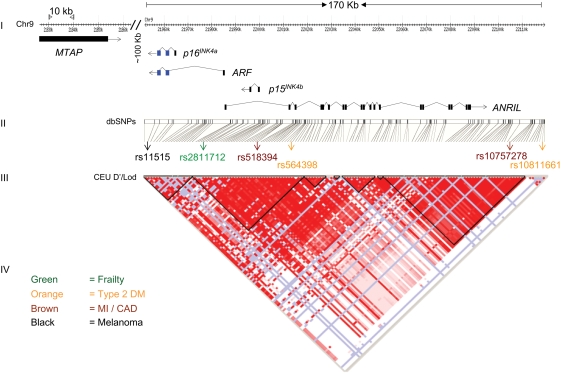
The human INK4/ARF locus and CAD associated SNPs.(I) INK4/ARF-associated transcripts and tested SNPs are shown as well as the location of MTAP, another gene at 9p21. Blue colored boxes indicate exons 2 and 3 shared by p16INK4a and ARF. The location of 9p21 SNPs (II) and linkage disequilibrium (LD) coefficient values (III) from HapMap[42] CEU (Utah residents with ancestry from northern and western Europe) are shown. The LD plot of D′/LOD was generated using Haploview software [42]. The strength of LD increases from white to blue to red: white (disequilibrium coefficient (D′) <1 and LOD score <2); blue (D′ = 1 and LOD score <2); pink (D′<1 and LOD score ≥2); and bright red (D′ = 1 and LOD score ≥2). (IV) The correlations with CAD and other age-associated conditions of the indicated SNPs are indicated by corresponding colors.